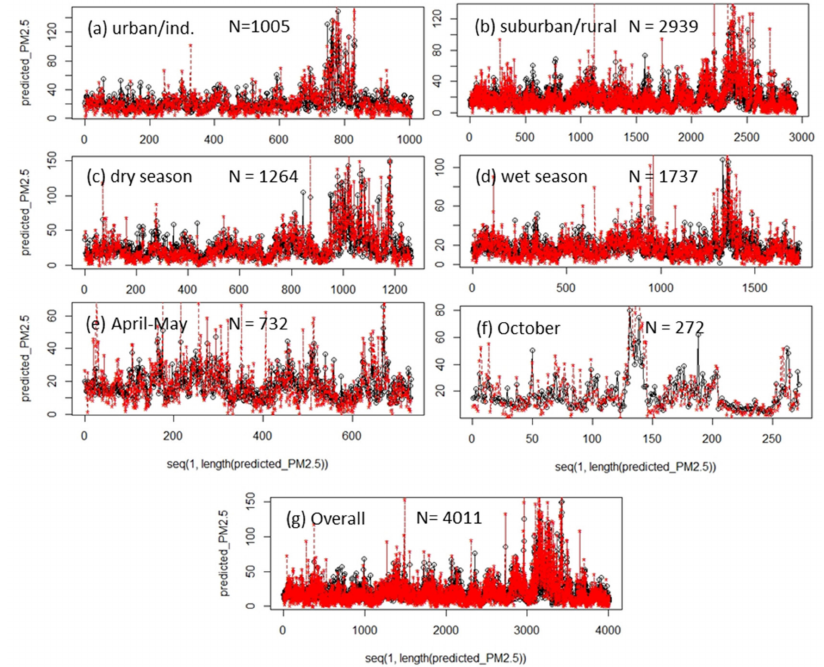
Figure 6. Time series (hourly) of measured (black) and predicted (red) PM 2.5 concentrations from the SVR model across Malaysia for urban/industrial ( a ), suburban/rural ( b ), dry season ( c ), wet season ( d ), April–May ( e ), October ( f ) and overall ( g ) models. The available data set for each group is mentioned in the panels. The X axis shows number of